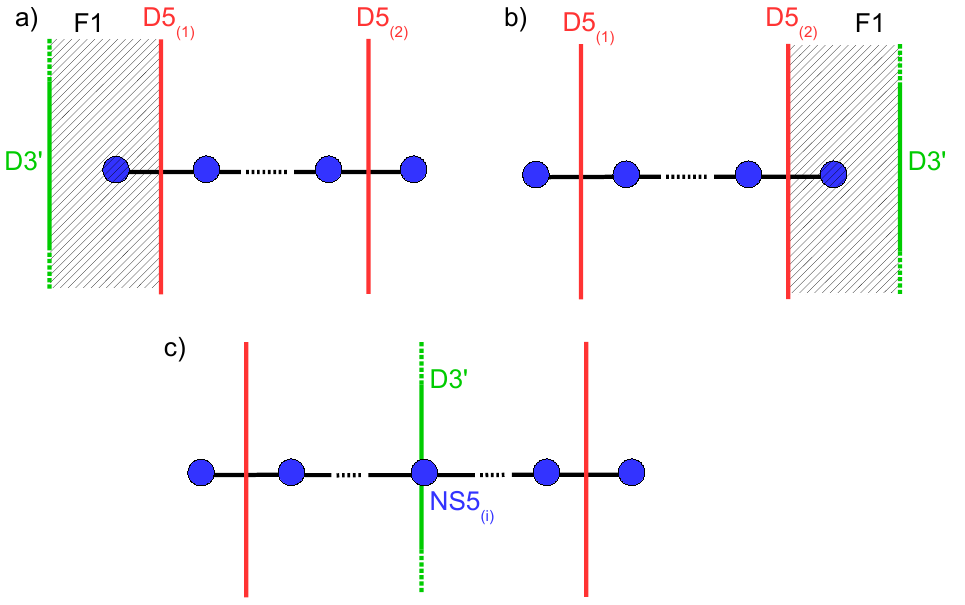
Figure 22 . Brane setups of the short mesons (a) X 0 These brane con(cid:12)gurations are all related by D3’ brane moves along x 3 and are ultimately a single brane